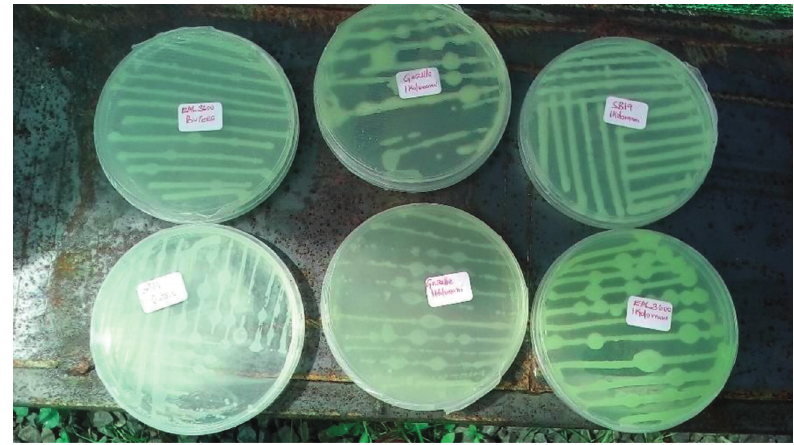
Figure 3: Plates showing rhizobia colonies. Table 2: Mean numbers of nodules, NDW, SDW, pods, pod weight, number of seeds, and weight of seeds.